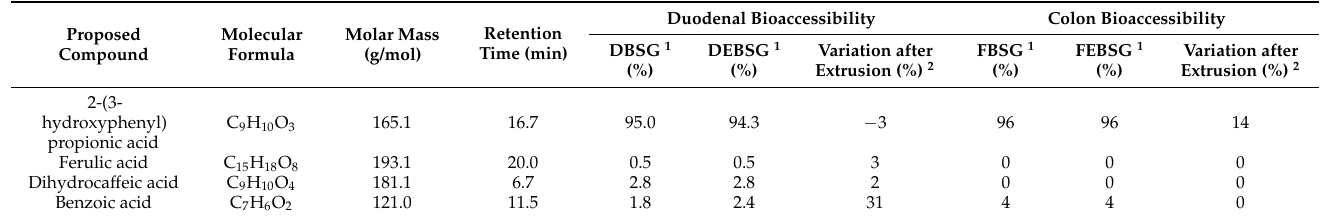
Table 4. Bioaccessibility of individual polyphenols in duodenal and colonic